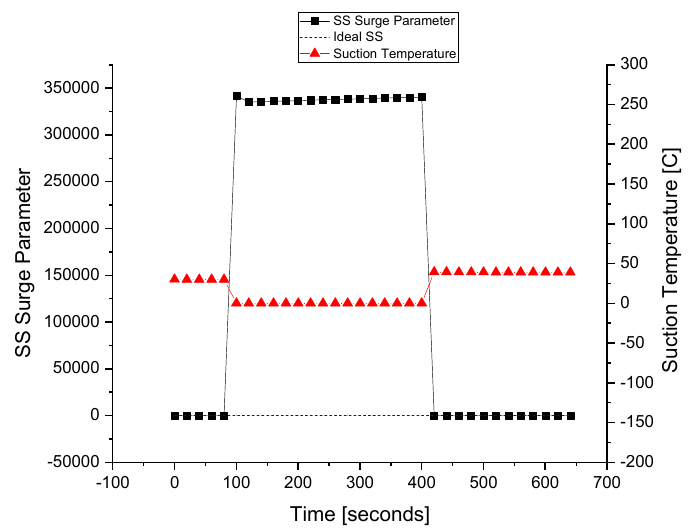
Figure 15. The fault tolerance in the suction temperature sensor.